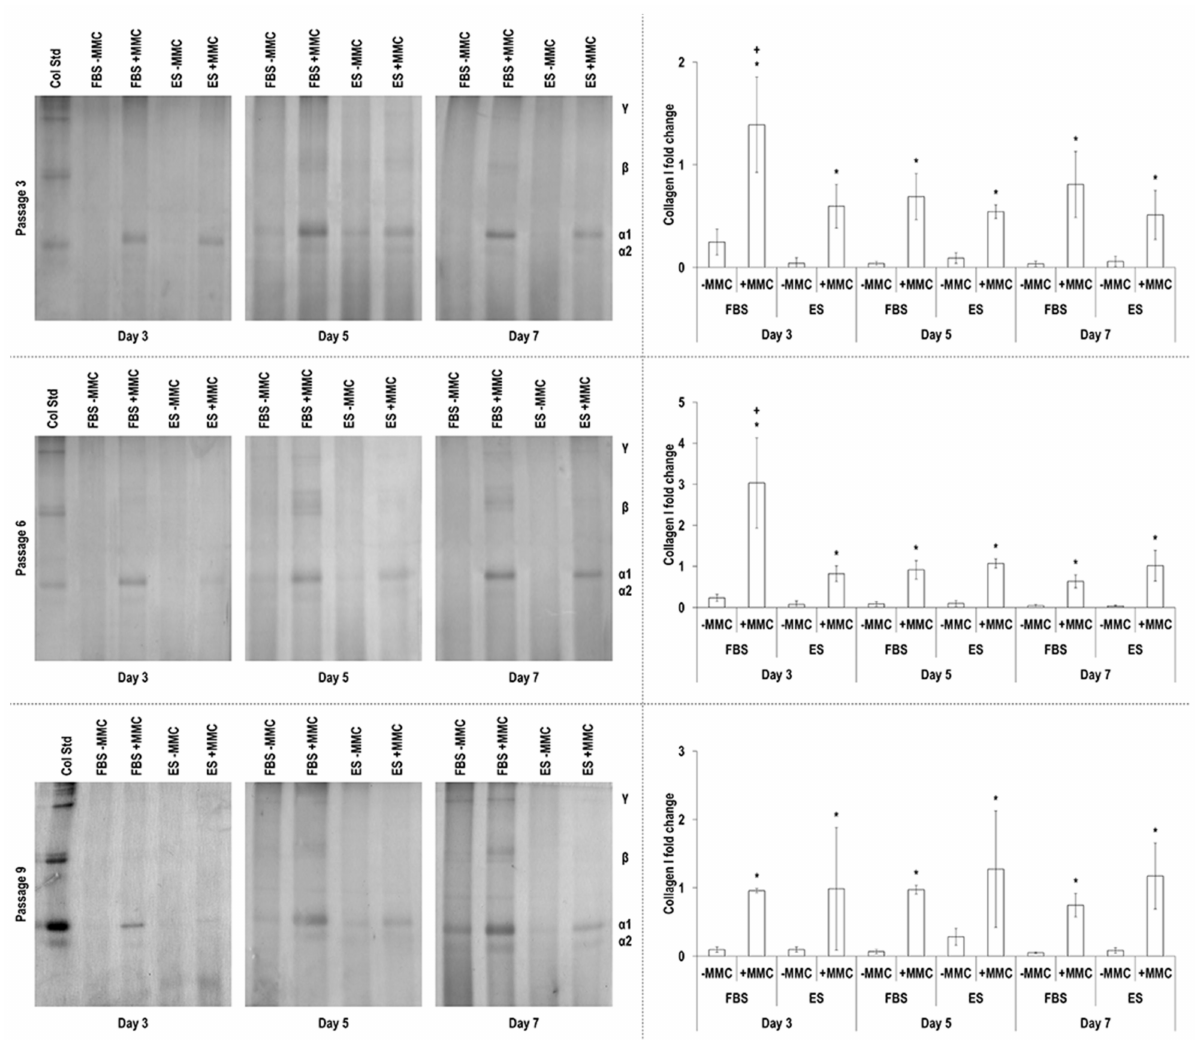
Figure 1. SDS-PAGE and densitometry analysis as a function of serum, passage, MMC and time in culture. + indicates the highest ( p < 0.05) value at a given passage. * indicates significant difference between the − MMC and the +MMC at a given passage, serum and time